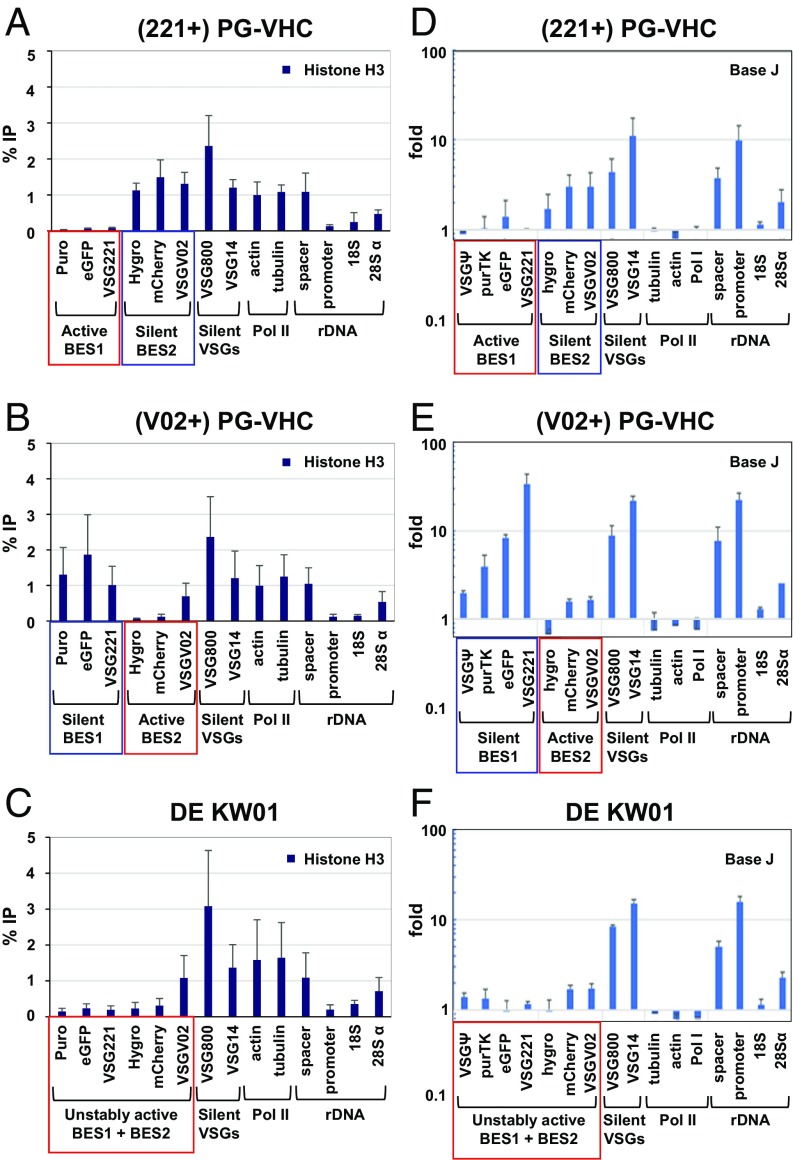
The unstably active ESs in the double-expresser DE KW01 strain have similar epigenetic features to the active ES in the parental single-expresser lines. The genes analyzed are indicated below, and include loci in the Pol I transcribed ESs and rDNA compared with Pol II transcription units. Data from the active ESs are indicated with red boxes and silent BESs with blue boxes. (A–C) The distribution of histone H3 was determined by using ChIP-qPCR in the single-expresser (221+)PG-VHC (A) or (V02+)PG-VHC (B) lines compared with the double-expresser DE KW01 line (C). Data are shown as the percentage of input immunoprecipitated (% IP) after subtraction of the no-antibody control. The mean of 3 independent ChIP-qPCR experiments is shown, with SD indicated with error bars. (D–F) The distribution of base J was determined by using J-IP-seq in the parental (221+)PG-VHC (D) or (V02+)PG-VHC (E) lines compared with DE KW01 (F). Fold enrichment was calculated for each gene as the ratio of median-normalized count in the J-IP library to the corresponding pre-IP library.